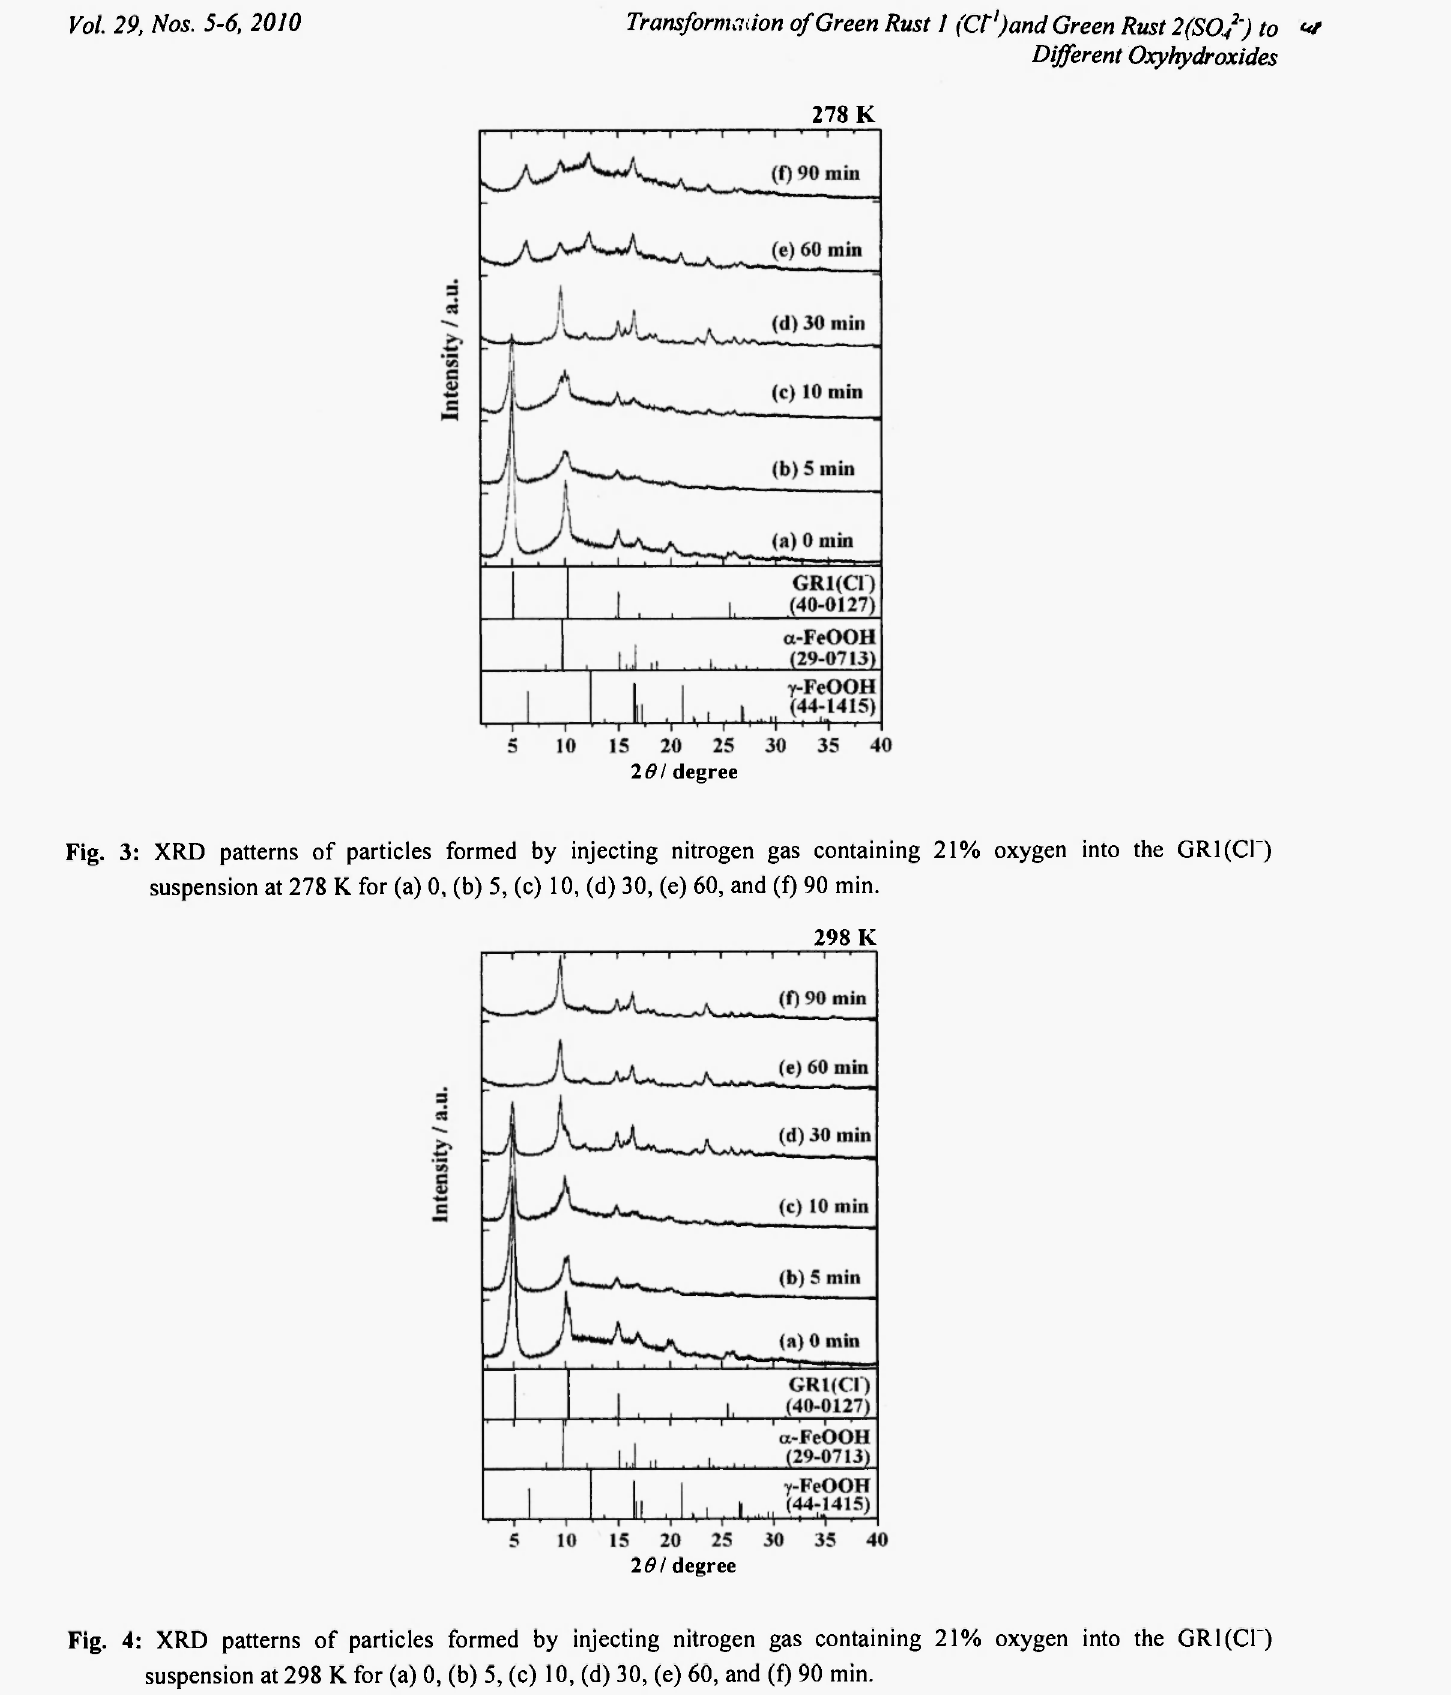
Fig. 4: XRD patterns of particles formed by injecting nitrogen gas containing 21% oxygen into the GRl(Cl ) suspension at 298 Κ for (a) 0, (b) 5, (c) 10, (d) 30, (e) 60, and (f) 90